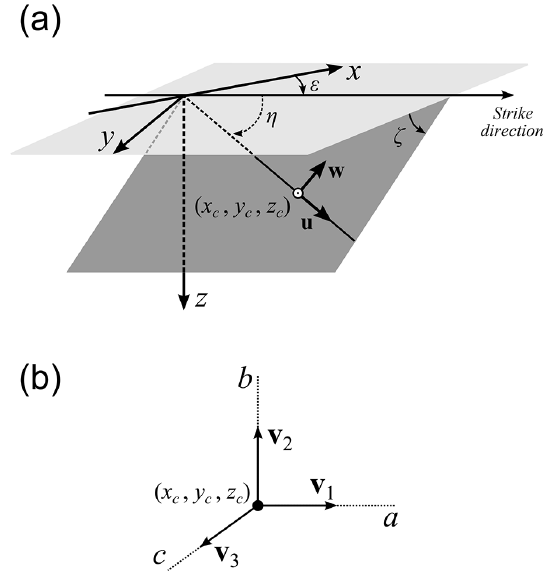
Figure 1. Schematic representation of the coordinate systems used to represent an ellipsoidal body. (a) Main coordinate system with axes x , y , and z pointing to north, east, and down, respectively. The dark grey plane contains the centre (x c ,y c ,z c ; white circle) and two unit vectors, u and w , defining two semi-axes of the ellipsoidal body. For triaxial and prolate ellipsoids, u and w define, respec- tively, the semi-axes a and b . For oblate ellipsoids, u and w define the semi-axes b and c , respectively. The strike direction is defined by the intersection of the dark grey plane and the horizontal plane (represented in light grey), which contains the x axis and y axis. The angle ε between the x axis and the strike direction is called strike. The angle ζ between the horizontal plane and the dark grey plane is called dip. The angle η between the strike direction and the line containing the unit vector u is called rake. The projection of this line on the horizontal plane (not shown) is called dip direction (Pollard and Fletcher, 2005; Allmendinger et al., 2012). (b) Local coordinate system with origin at the ellipsoid centre (x c ,y c ,z c ) (black dot) and axes defined by unit vectors v 1 , v 2 and v 3 . These unit vectors define the semi-axes a , b and c of triaxial, prolate and oblate ellipsoids in the same way. For triaxial and prolate ellipsoids, the unit vectors u and w shown in (a) coincide with v 1 and v 2 , respectively. For oblate ellipsoids, the unit vectors u and w shown in (a) coincide with v 2 and v 3 ,